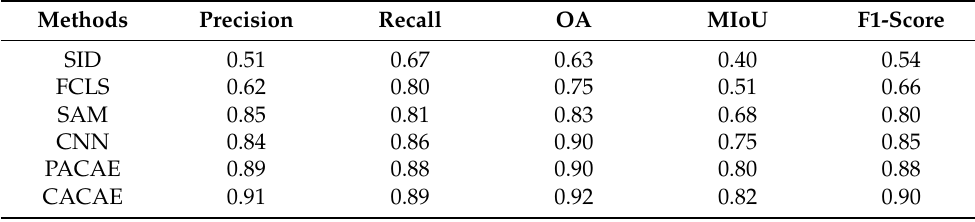
Table 6. Quantitative analysis of prediction results on the Urban dataset.